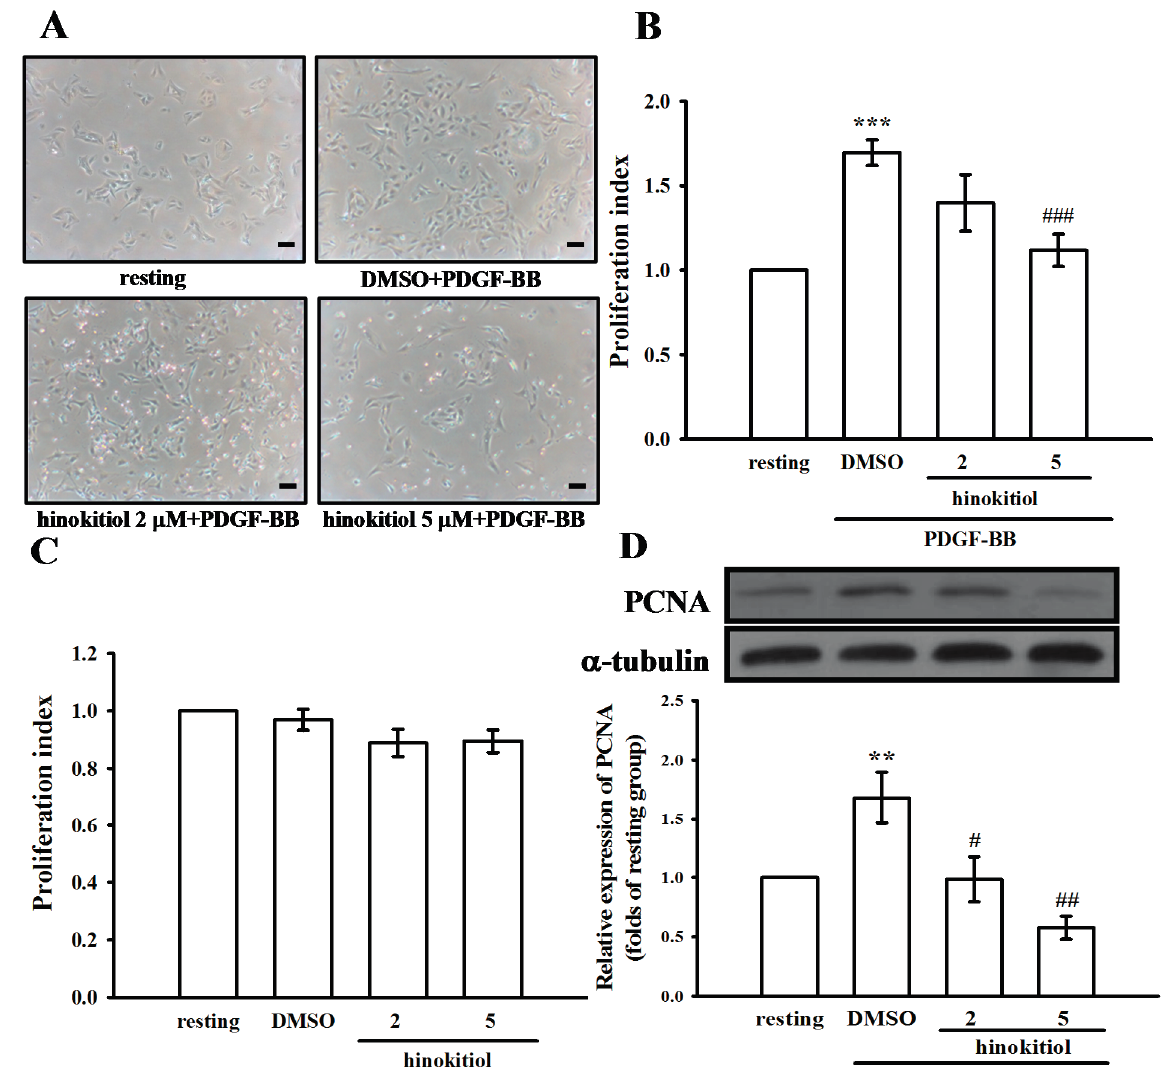
Figure 2. Effects of hinokitiol on the platelet-derived growth factor (PDGF)-BB-induced proliferation of vascular smooth muscle cells (VSMCs). ( A ) Morphological changes in VSMCs co-treated with PDGF-BB (10 ng/mL) and hinokitiol (2 and 5 µM) for 24 h were observed (scale bar = 100 µm); ( B ) VSMCs were co-treated with hinokitiol (2 and 5 µM) and PDGF-BB (10 ng/mL) for 24 h, and cell proliferation was determined using the MTT assay; ( C ) VSMCs were treated with hinokitiol (2 and 5 µM) alone for 24 h, and cell proliferation was determined using the MTT assay; ( D ) VSMCs were pre-trated in a serum-free medium in the presence or absence of hinokitiol (1–5 μ M) for 24 h, and then stimulated with 10 ng/mL PDGF-BB for 24 h. VSMCs were stained with anti-PCNA antibody, and its protein expression levels were determined by immunoblotting analysis. Data are presented as the mean ± S.E.M. (A–C, n = 3; D, n = 4) ** p < 0.01 and *** p < 0.001 compared to the normal cells, # p < 0.05, ## p < 0.01, and ### p < 0.001, compared to the PDGF-BB stimulated